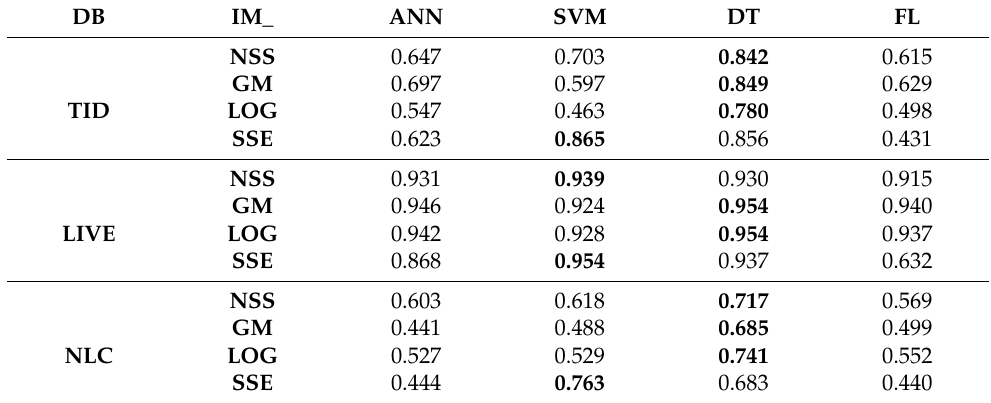
Table 5. Spearman’s correlation between intermediary metrics and MOS for different image databases.